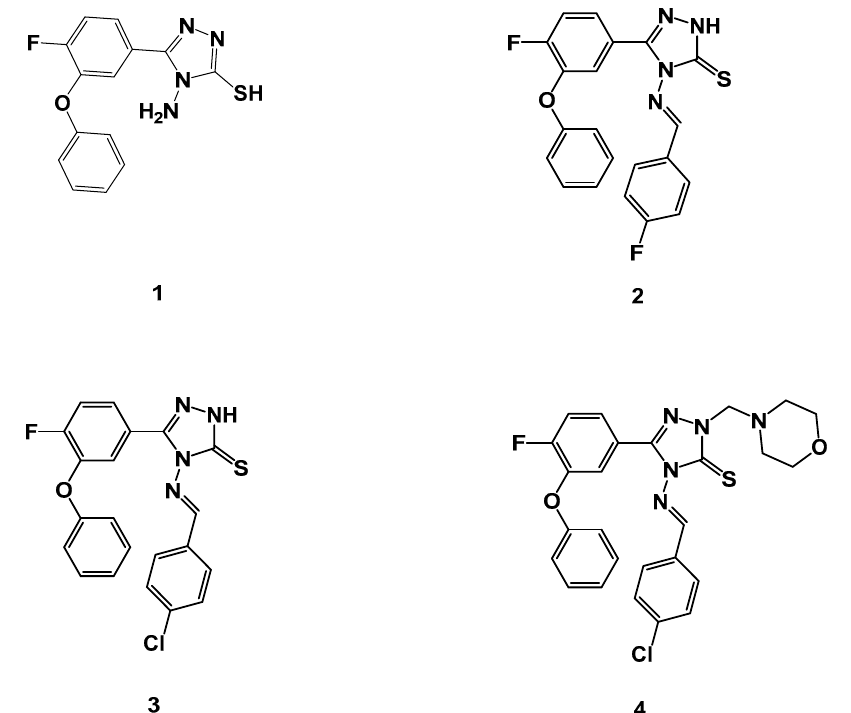
Figure 2. Molecular structures of triazole parent compound 1 , and its Schi ff bases 2 , 3 , and 4 were tested for their in vitro anti-TB activity against H37Rv and multi-drug-resistant (MDR) strains of Mycobacterium tuberculosis